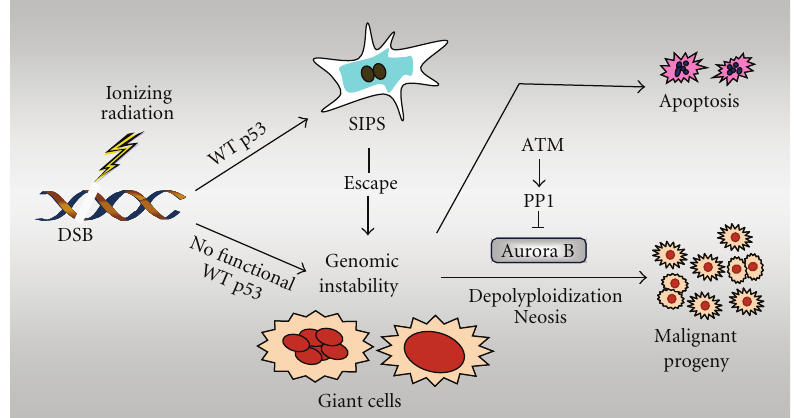
Figure 8: Formation and fate of multinucleated/polyploid giant cancer cells. Ionizing radiation triggers the development of giant cells within cultures of cancer cells lacking wild-type (WT) p53 function. In addition, although p53 wild-type cancer cells respond to ionizing radiation by undergoing SIPS, a small proportion of cells “escape” from the SIPS response and give rise to multinucleated/polyploid giants. While some giant cells may die through apoptosis, others may undergo complex genome-reduction processes (e.g., depolyploidization; neosis), ultimately giving rise to rapidly-proliferating progeny. The mitotic kinase Aurora B plays an important role in regulating the survival of giant cells. Recent evidence suggests that ATM may prevent the propagation of giant cells and their descendants by activating protein phosphatase 1 (PP1) and inhibiting Aurora B kinase activity (for details, consult [34]).